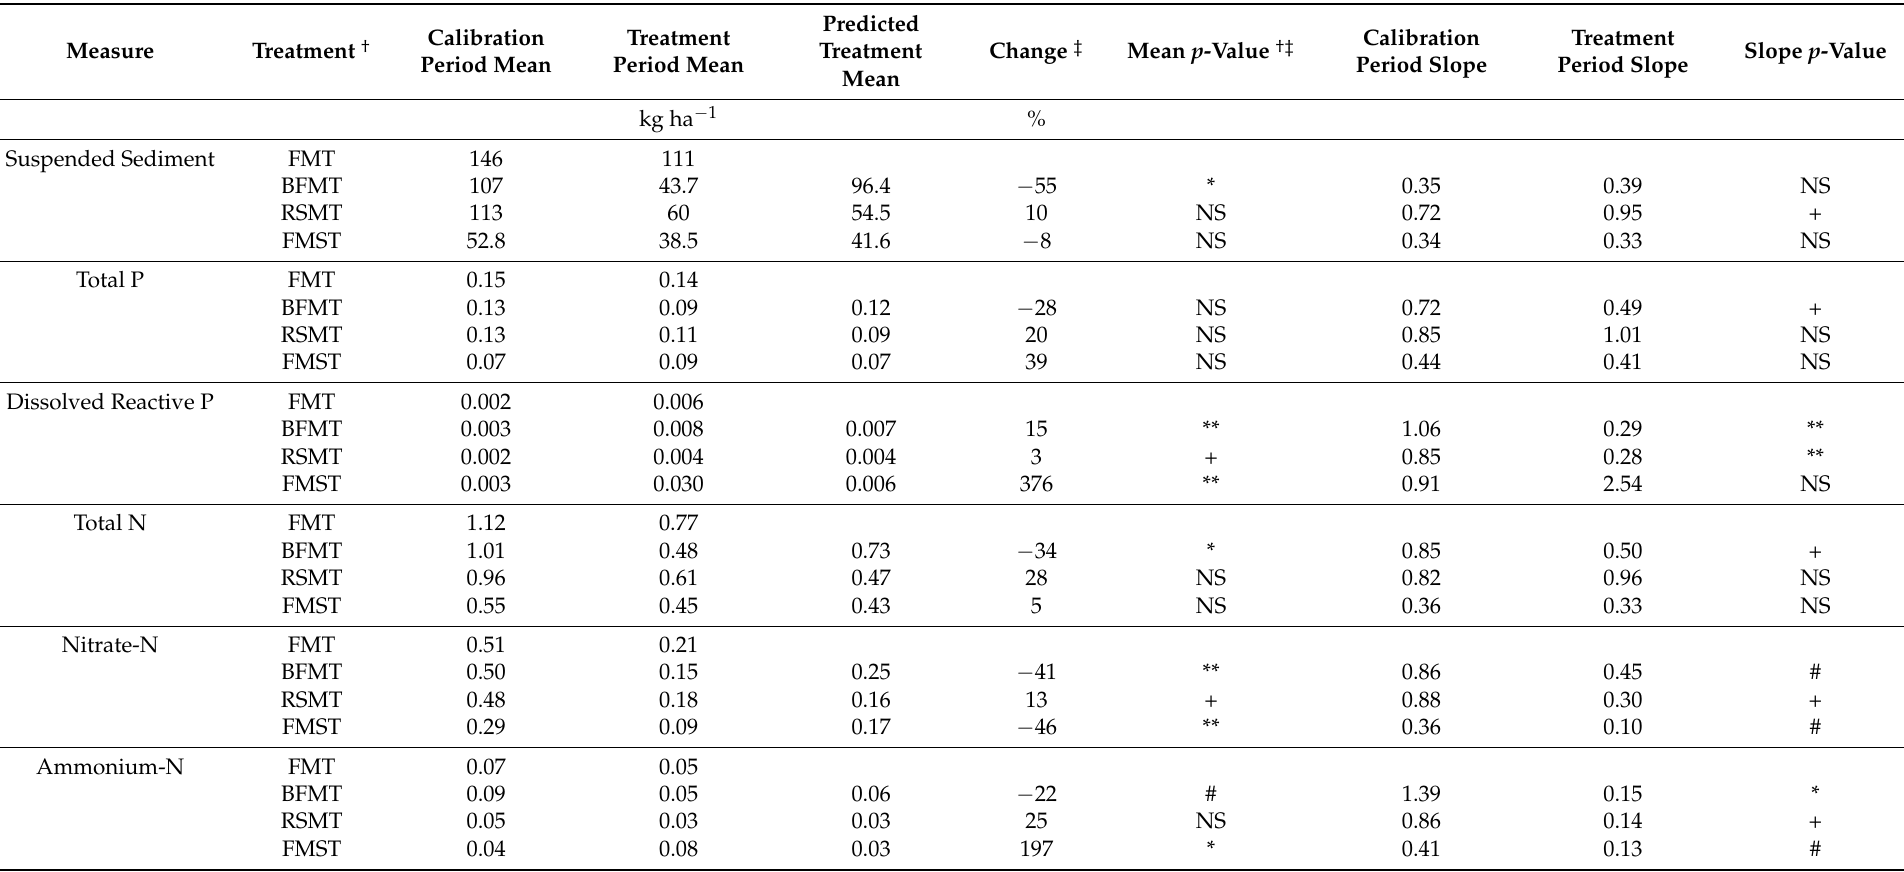
Calibration Treatment Slope p -Value Period Slope Period Slope